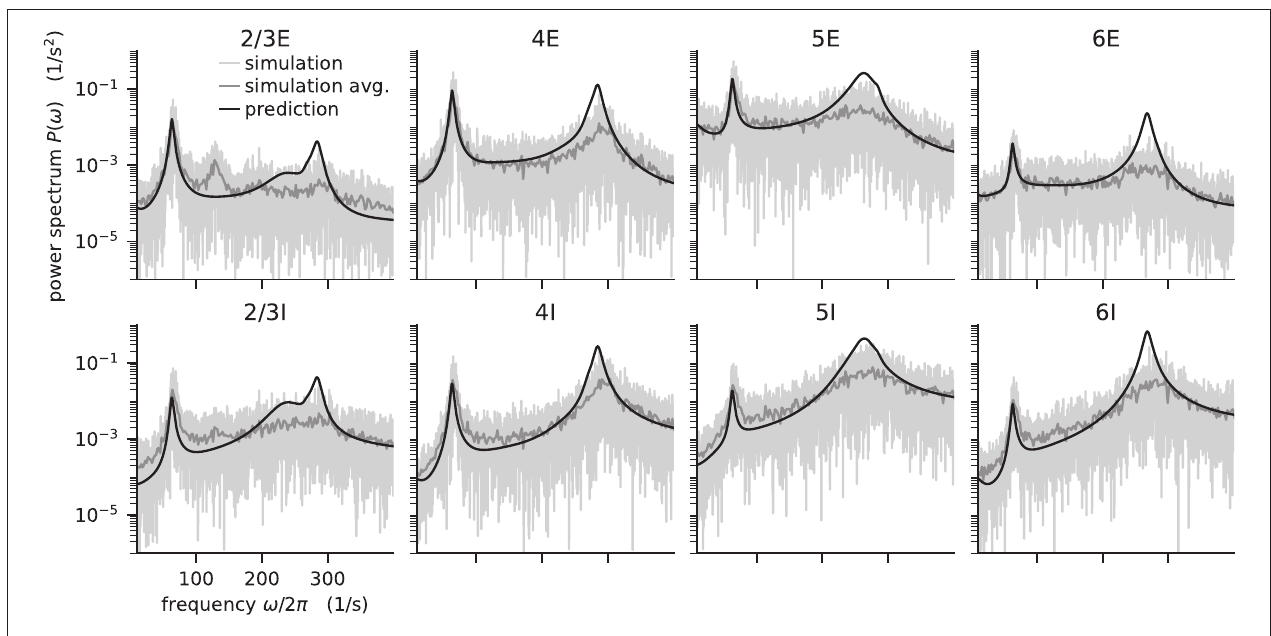
FIGURE 5 | Power spectra of the population spiking activity in the adapted cortical microcircuit from Bos et al. (2016). The spiking activity of each population in a 10s simulation of the model is binned with 1ms resolution and the power spectrum of the resulting histogram is calculated by a fast Fourier transform (FFT; light gray curves). In addition, the simulation is split into 500ms windows, the power spectrum calculated for each window and averaged across windows (gray curves). Black curves correspond to analytical prediction obtained with NNMT as described in Listing 5 . The panels show the spectra for the excitatory (top) and inhibitory (bottom) populations within each layer of the